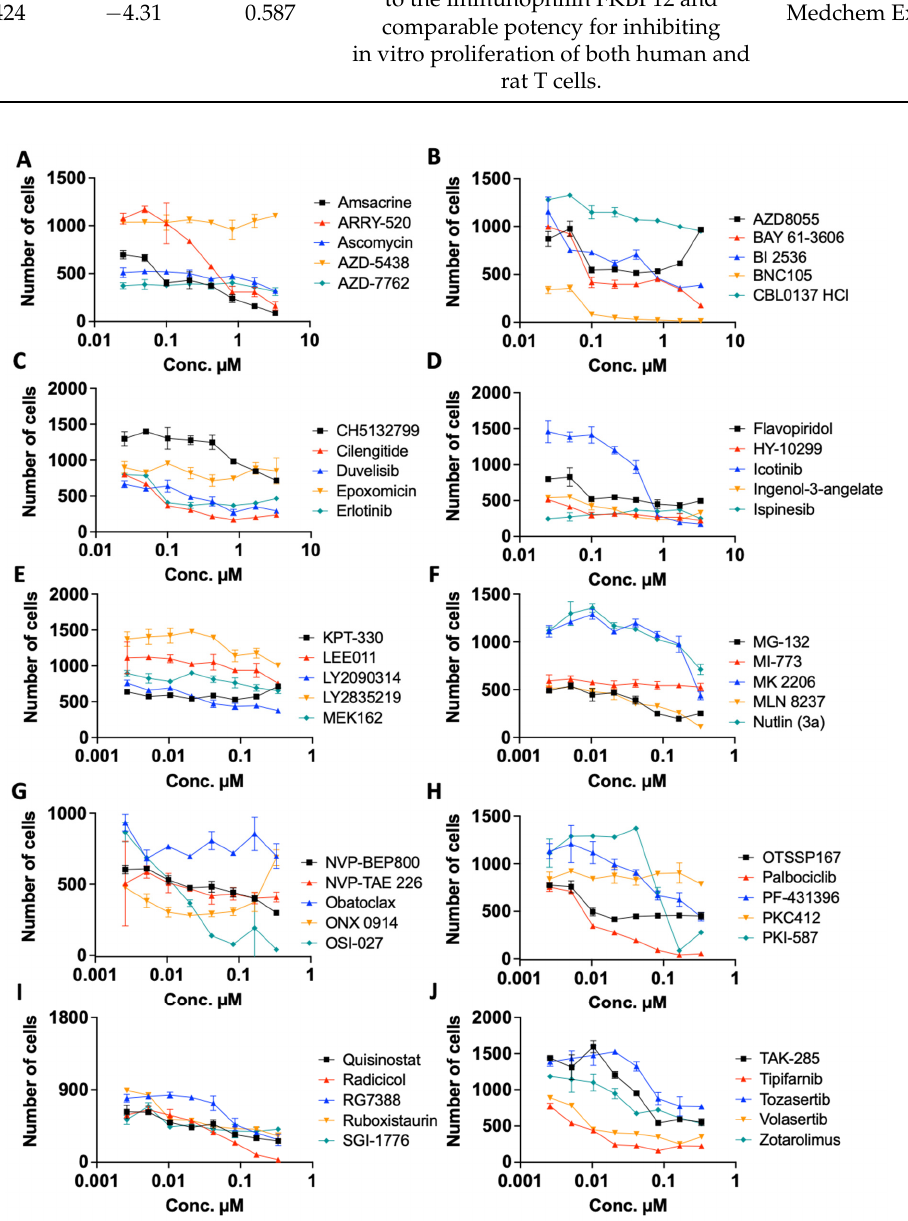
Figure 3. Reconfirmation of potential hits from primary assays and dose dependency studies identifies proteasomal inhibitors . ( A – J ) Dose-response curves for cherry-picked compounds from primary screening done in duplicate. ( F ) Dose dependency curves for three proteasomal inhibitors showing recon fi rmation of these three inhibitors. ( G , H ) Dose dependency curves for BNC105 and bortezomib or Palbociclib alone or in combination showing low-dose synergistic cell-killing activity of chordoma cells.